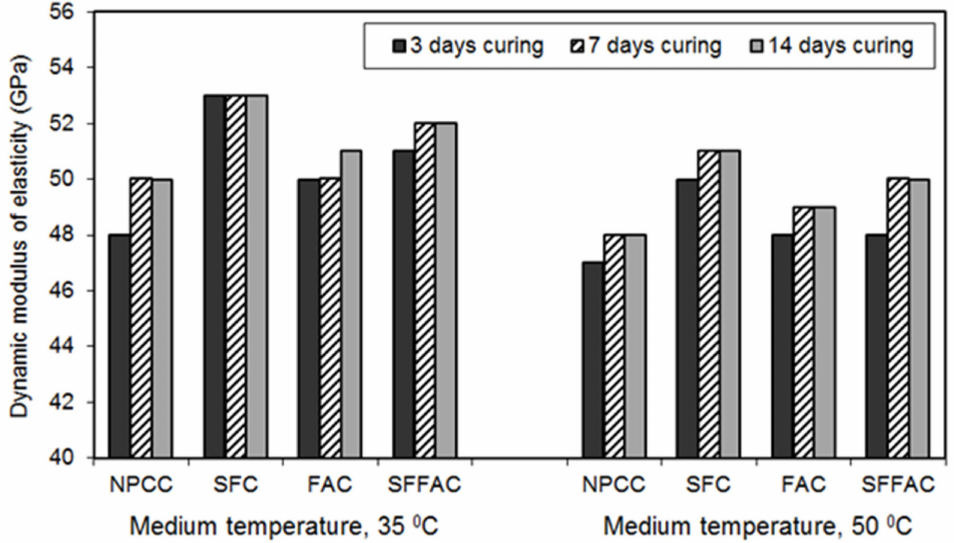
Figure 6. The 28-day dynamic modulus of elasticity of different types of concrete transferred after 3, 7 and 14 days of water curing at 20 ˝ C followed by exposure to two medium temperatures of 35 ˝ C and 50 ˝ C.